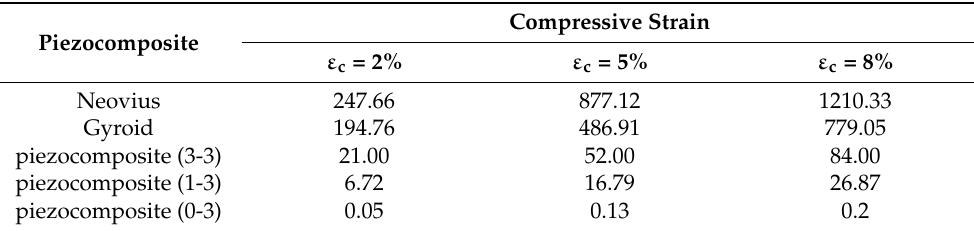
Table 4. Output voltage of piezocomposites with 16% ceramic volume fraction (Reprinted from Ref. [82], copyright (2020), with the kind permission of Elsevier